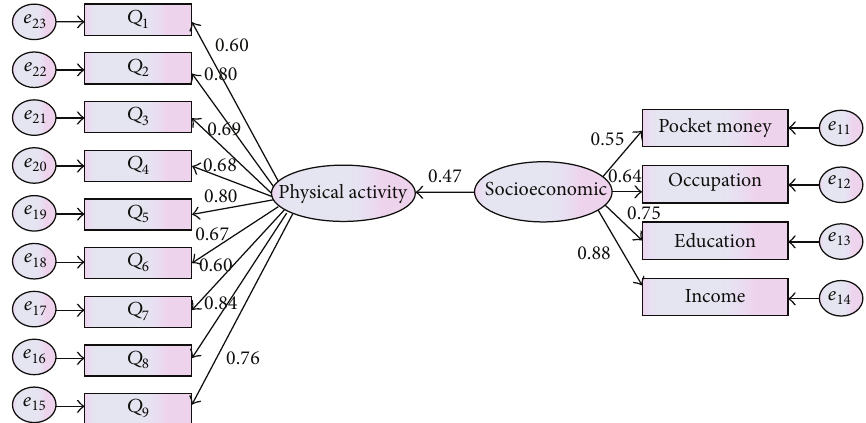
Figure 8: Standardized path coefficients and residual variance in the second model.